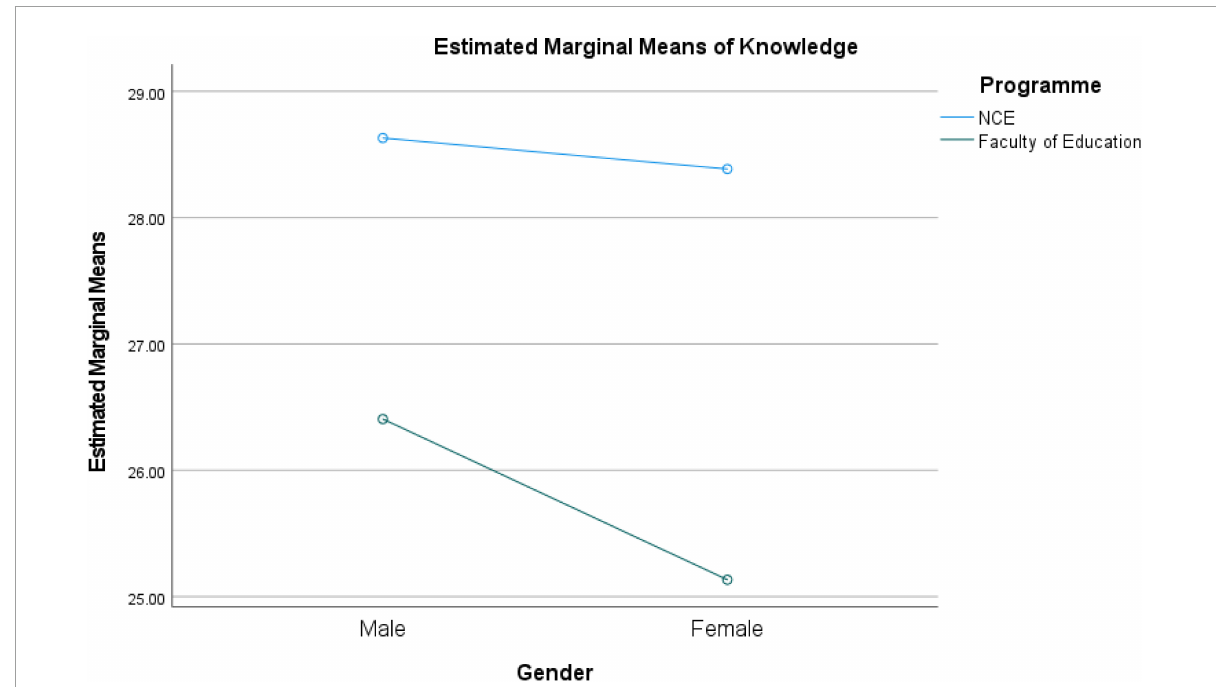
FIGURE1 Estimated marginal means interaction between gender and programs on pre-service teacher knowledge about inclusive education.